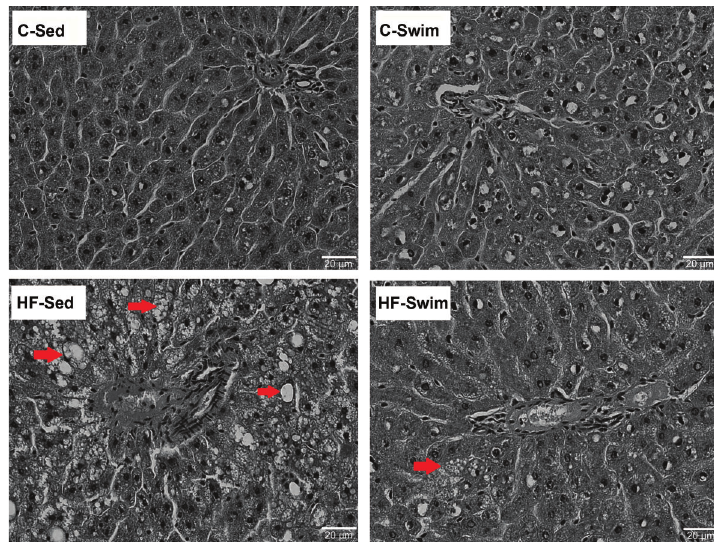
Figure 4. Histological analysis of liver from rats fed standard rodent chow and a high-fat diet. Representative microphotographs of hematox- ylin-eosin-stained sections (bar=20 m m) are shown. Red arrows indicate fat accumulation. C-Sed: sedentary control group; C-Swim: exer- cised control group; HF-Sed: sedentary high-fat diet group; HF-Swim: exercised high-fat diet